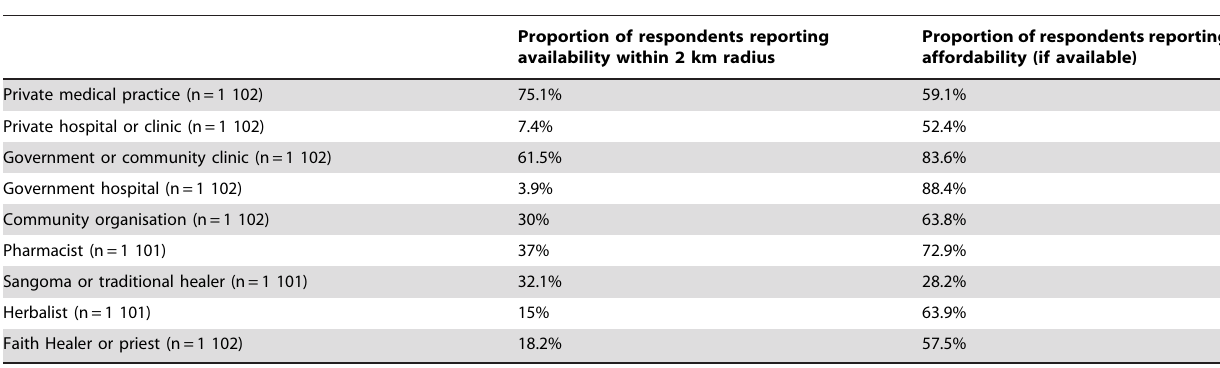
Table 2. Access to Healthcare Services in